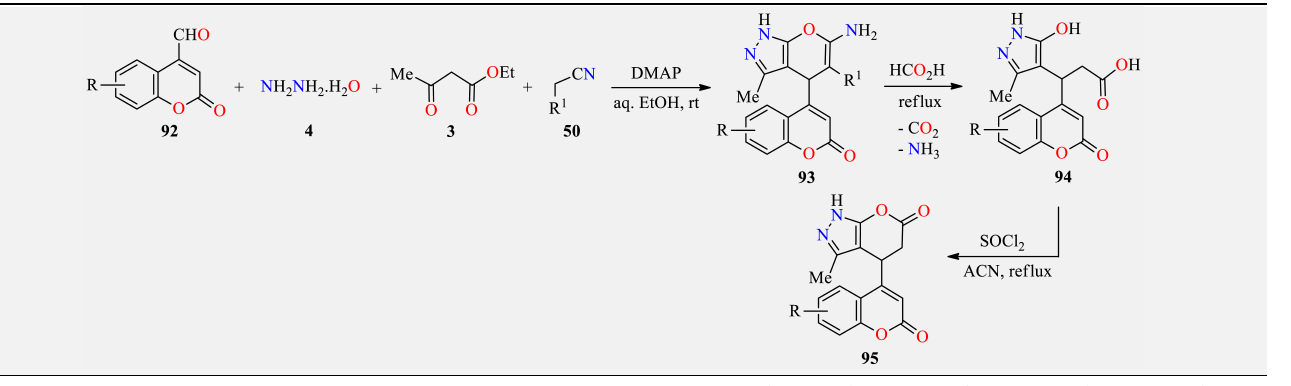
Table 26. Four-component synthesis of coumarin-substituted pyrazoles 93 , 94 , and 95 and their in vitro antibacterial activity (MIC) against four bacterial